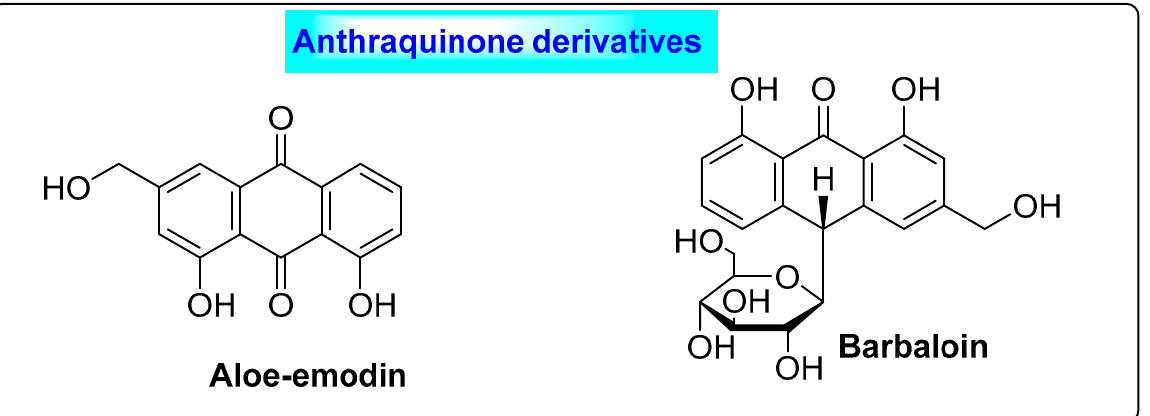
Figure 12. Secondary metabolites of Aloe vera responsible for altering enzymatic activity, which could be beneficial in PCOS.